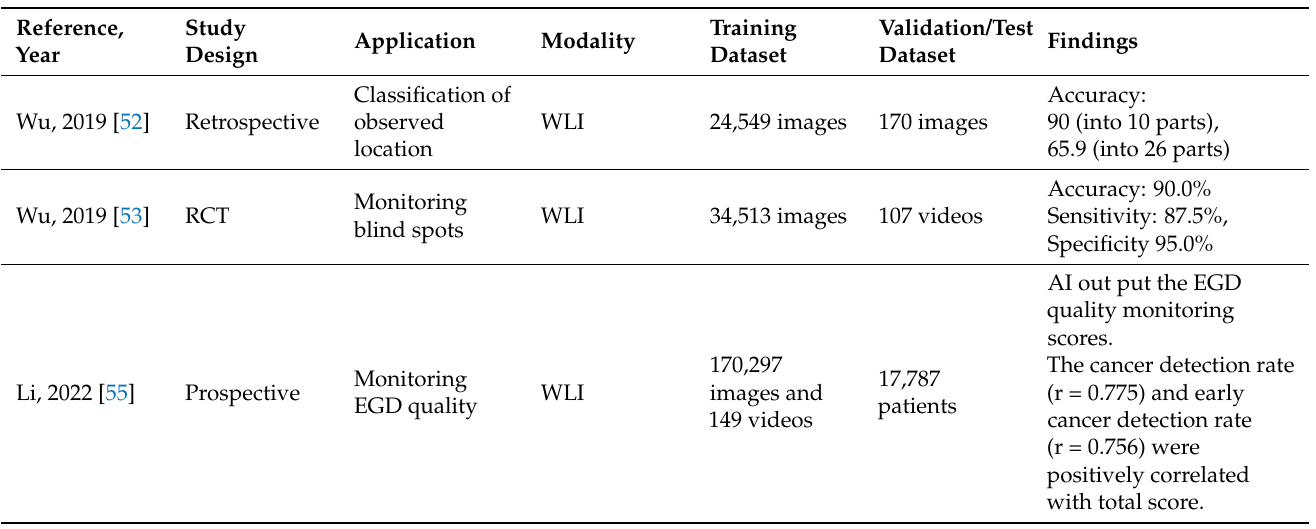
Table 4. Summary of CAD for examination quality